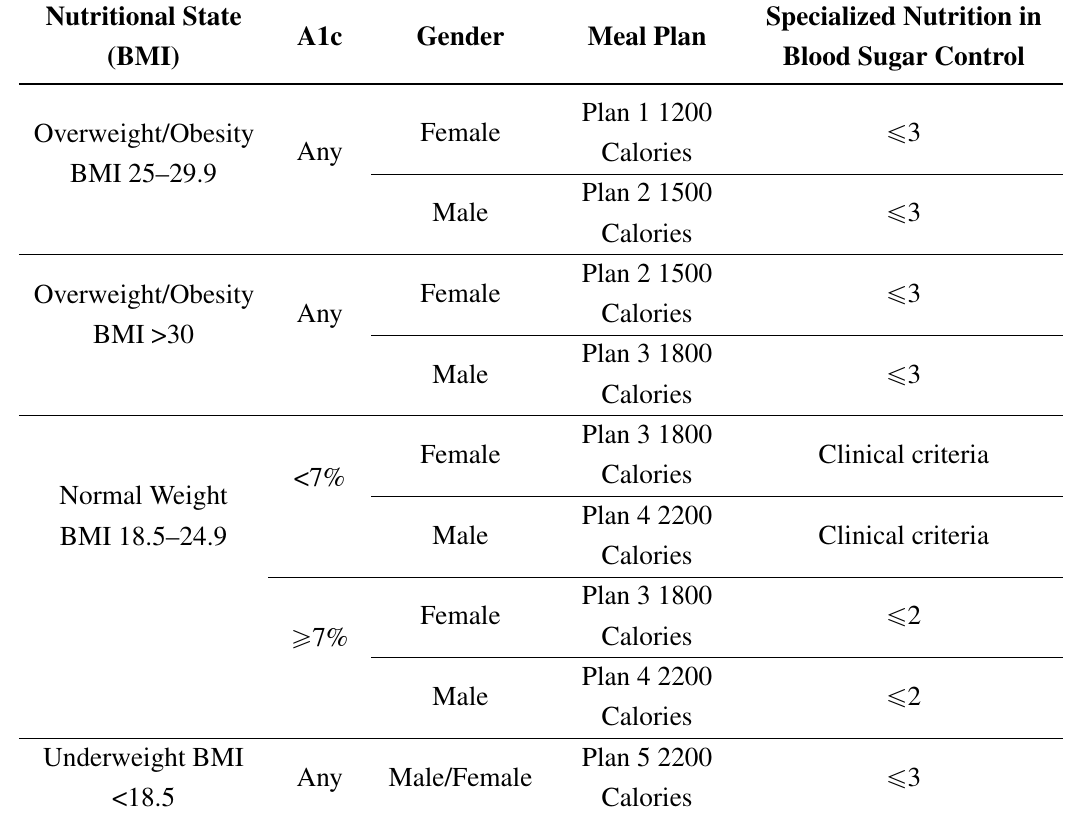
Table 7. Caloric Needs and GTSN Recommendations Based on Gender, BMI and A1c. Nutritional State